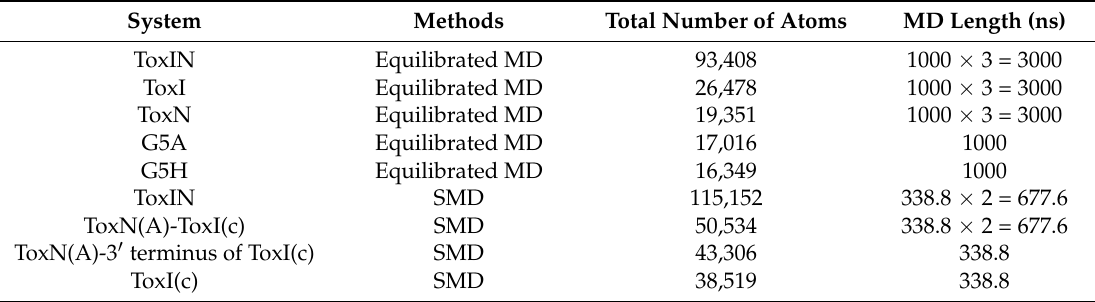
Table 1. Systems for molecular dynamics (MD)